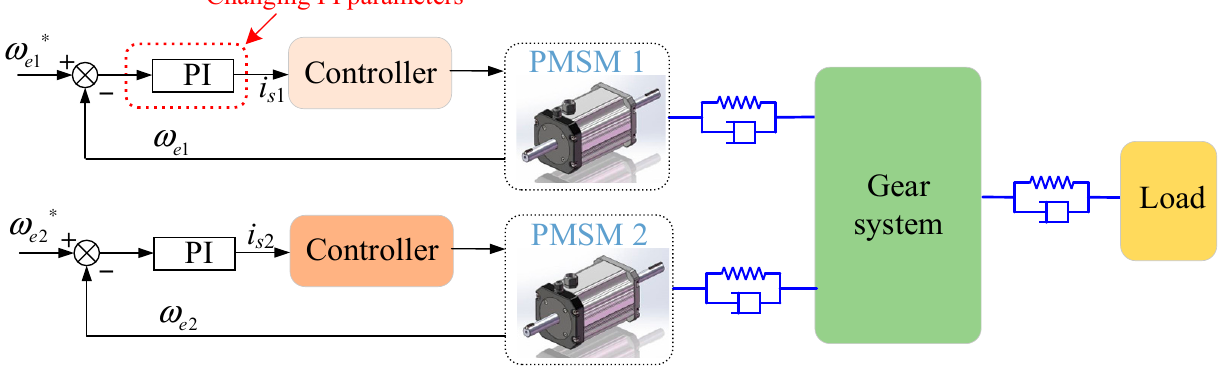
Figure 24. Schematic diagram of PI parameter changes of the speed loop of motor 1. The load of DEDS changes abruptly from 1155 Nm to 2310 Nm in 1.5 s. Figure 25b shows the relationship between motor 1’s speed and the speed synchronization error under different PI parameters. After changing the speed ring parameters of motor 1, the speed of motor 1 fluctuates to different degrees, and the synchronization error increases with the increase in the fluctuation amplitude of motor 1’s speed. The synchronization error under case 3 is the largest, and the synchronization error under case 1 is the